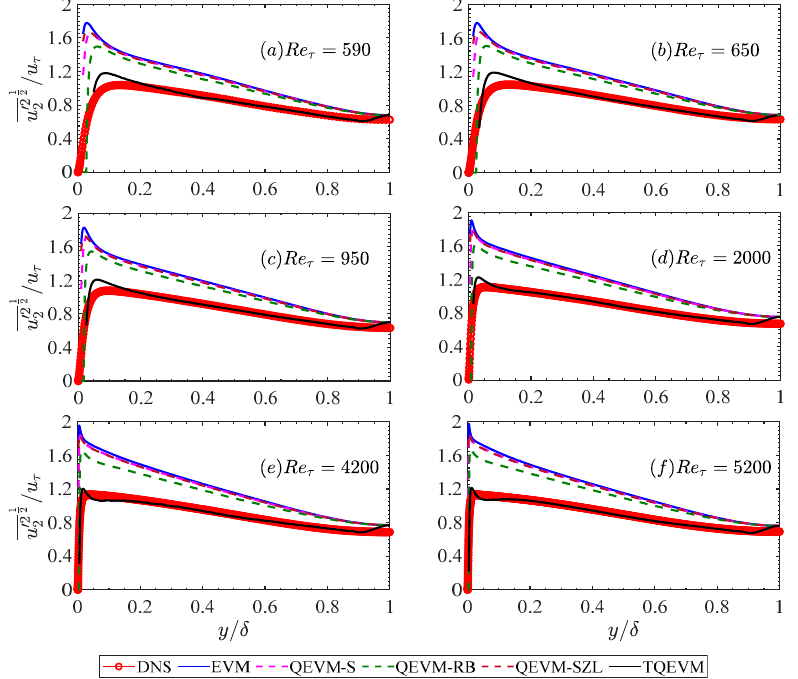
21/2 Figure 7. Dimensionless normal Reynolds stress u (cid:48) 2 / u τ as a function of dimensionless wall distance Figure 7. Dimensionless normal Reynolds stress (cid:1873) (cid:4593) (cid:2870)(cid:2870) (cid:3364)(cid:3364)(cid:3364)(cid:3364) (cid:2869) (cid:2870)⁄ (cid:1873) (cid:3099) (cid:3415) as a function of dimensionless wall distance (cid:1877) (cid:2012)⁄ y / δ for ( a ) Re τ = 590, ( b ) Re τ = 650, ( c ) Re τ = 950, ( d ) Re τ = 2000, ( e ) Re τ = 4200, and ( f ) Re τ = 5200 for ( a ) (cid:1844)(cid:1857) (cid:3099) = 590 , ( b ) (cid:1844)(cid:1857) (cid:3099) = 650 , ( c ) (cid:1844)(cid:1857) (cid:3099) = 950 , ( d ) (cid:1844)(cid:1857) (cid:3099) = 2000 , ( e ) (cid:1844)(cid:1857) (cid:3099) = 4200 , and ( f ) (cid:1844)(cid:1857) (cid:3099) = 5200 Figure 7. Dimensionless normal Reynolds stress (cid:1873) (cid:4593) (cid:2870)(cid:2870) (cid:3364)(cid:3364)(cid:3364)(cid:3364) (cid:2869) (cid:2870)⁄ (cid:1873) (cid:3099) (cid:3415) as a function of dimensionless wall distance (cid:1877) (cid:2012)⁄ obtained from DNS, EVM, QEVM-S, QEVM-RB, QEVM-SZL, and the proposed obtained from DNS, EVM, QEVM-S, QEVM-RB, QEVM-SZL, and the proposed TQEVM. for ( a ) (cid:1844)(cid:1857) (cid:3099) = 590 , ( b ) (cid:1844)(cid:1857) (cid:3099) = 650 , ( c ) (cid:1844)(cid:1857) (cid:3099) = 950 , ( d ) (cid:1844)(cid:1857) (cid:3099) = 2000 , ( e ) (cid:1844)(cid:1857) (cid:3099) = 4200 , and ( f ) (cid:1844)(cid:1857) (cid:3099) = 5200 obtained from DNS, EVM, QEVM-S, QEVM-RB, QEVM-SZL, and the proposed TQEVM.